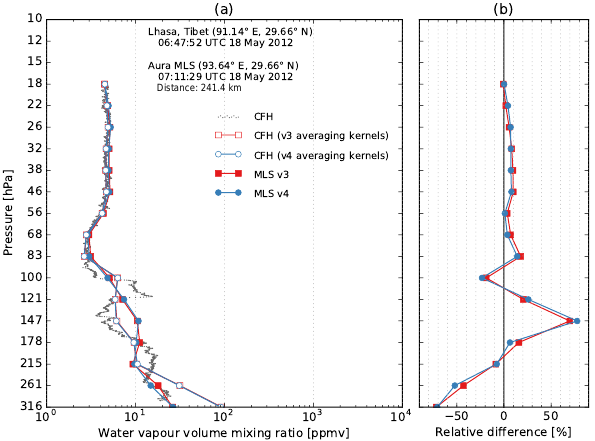
Figure 7. As in Fig. 3, but for CFH, MLS v3 and MLS v4 profiles of water vapour volume mixing